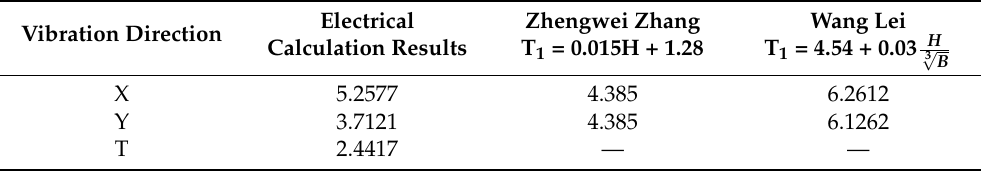
Table 3. Comparison of the electro-computed results with those obtained from the existing fitted empirical